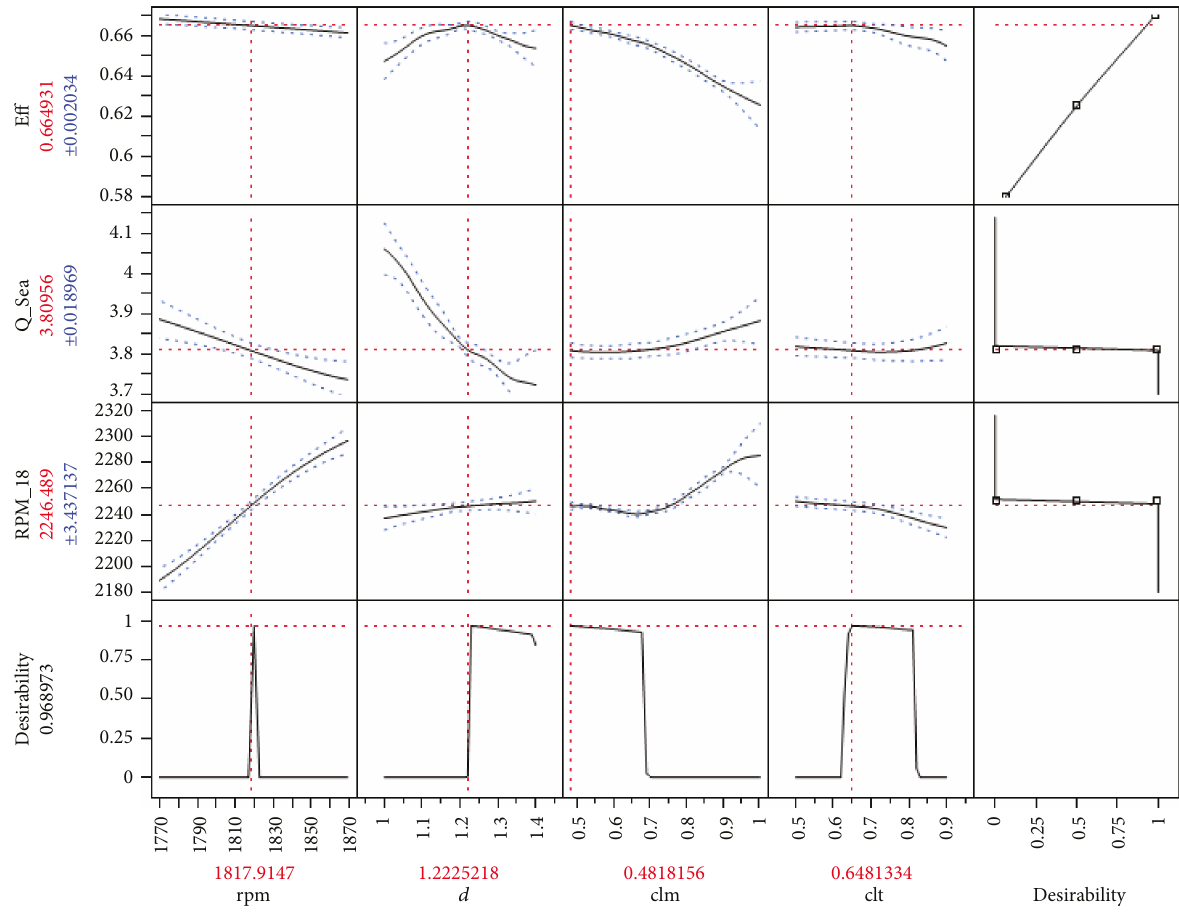
Figure 10: Optimization based on desirability function in JMP. Table 5: Comparison of optimization and fi nal adjusted design of the EAV-3